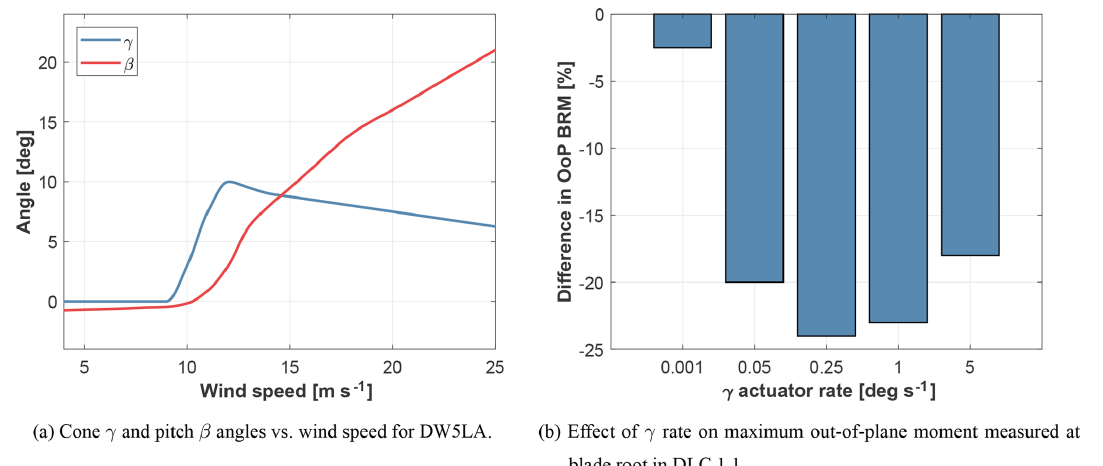
Figure 3. Cone and cone rate for the DW5LA